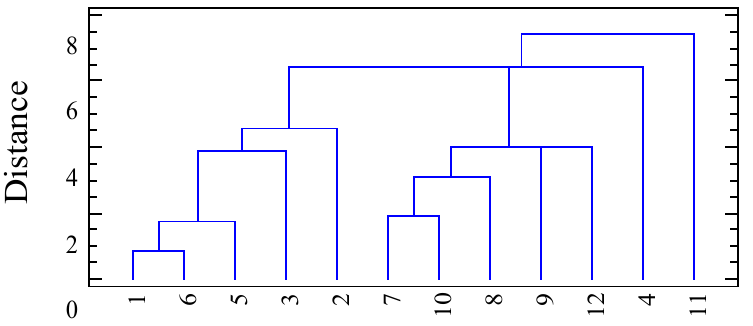
Fig. 1. Genetic grouping of pumpkin populations by cluster